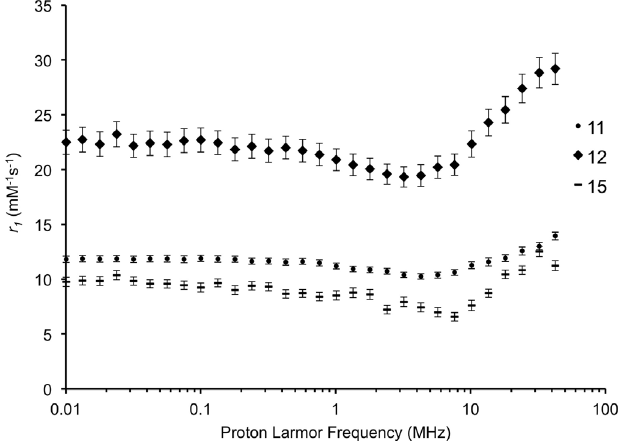
polymersome 12 , and polymersome 15 in phosphate buffer (0.1 M, pH 7.4) as a function of field strength at 298